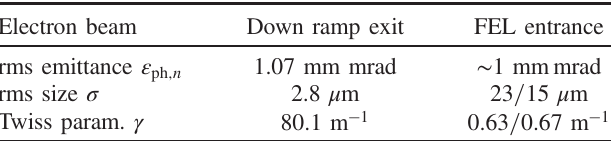
TABLE III. Characteristics of the electron beam obtained at the down ramp exit and as required at the FEL entrance.